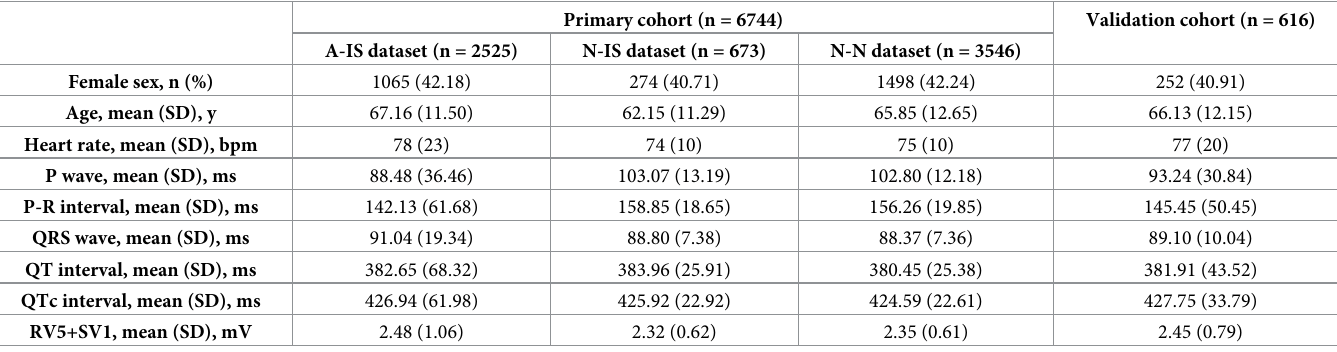
Table 1. Demographics and ECG parameters of participants from the primary cohort and validation